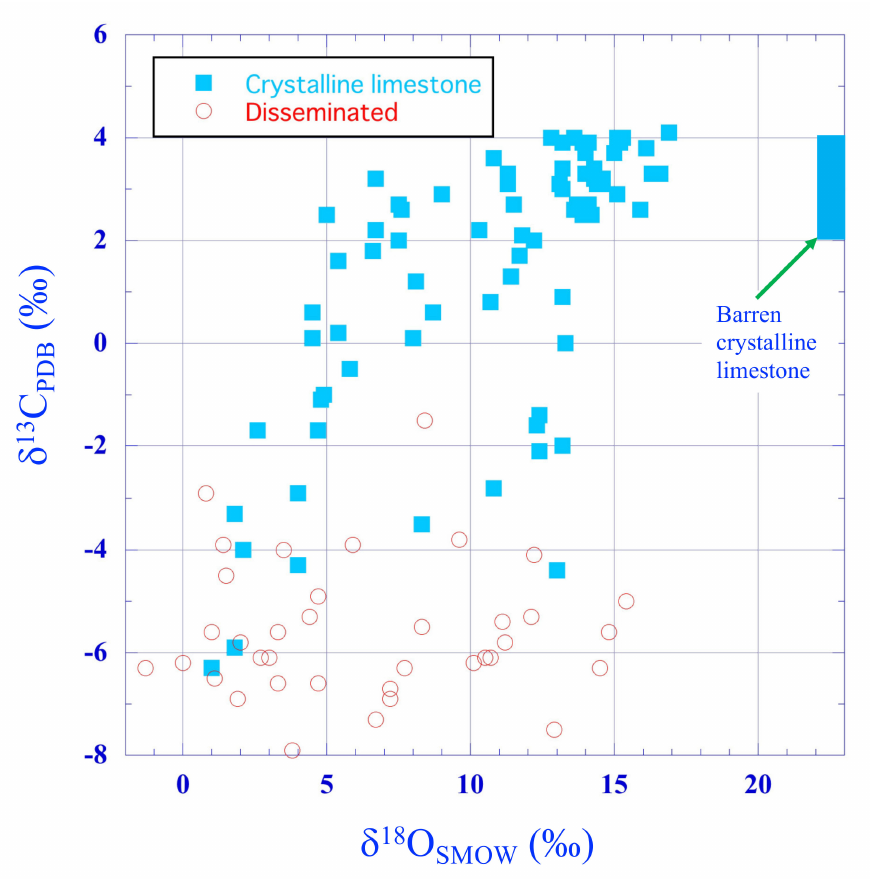
Figure 4. The δ 13 C and δ 18 O values of crystalline limestone and disseminated fissure-filling calcite from drill holes 4MAHS-5 and 4MAHS-6 in the Sakonishi area (the isotope data are from [2]). The square box in blue indicates the range of the δ 13 C and δ 18 O values of barren crystalline limestone from the Sommbo-dani and Kirimo-dani areas [2]. It is assumed that the range of the square box indicates the isotope ratios of crystalline limestone that underwent the Hida metamorphism but not ore